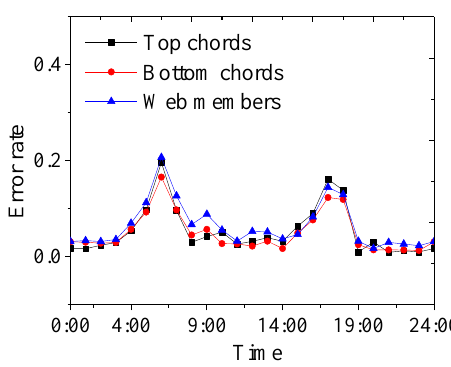
Figure 12. Average error rate curves of different type members.